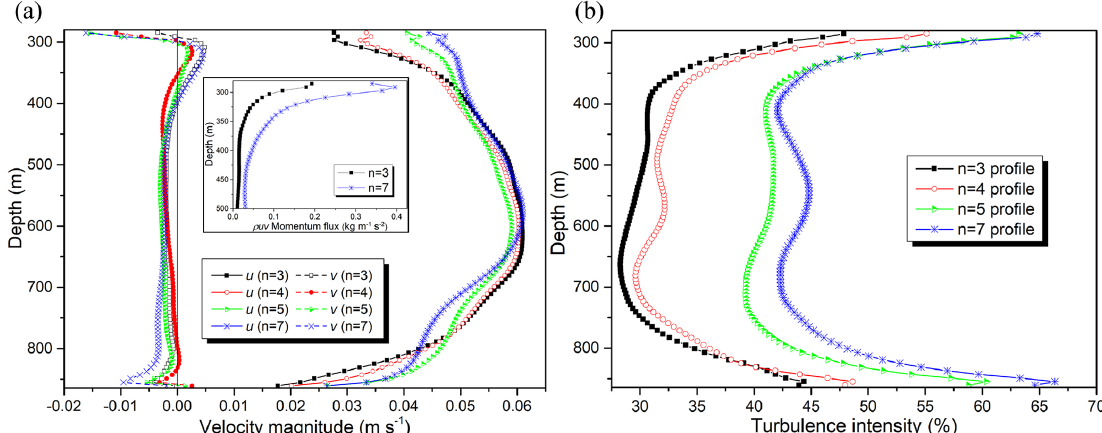
Figure 8. Vertical profiles of (a) u and v mean velocities and (b) turbulence intensity. The inset in panel (a) shows the vertical profile of the horizontal momentum flux for the Ekman layer formation beneath the ice shelf.